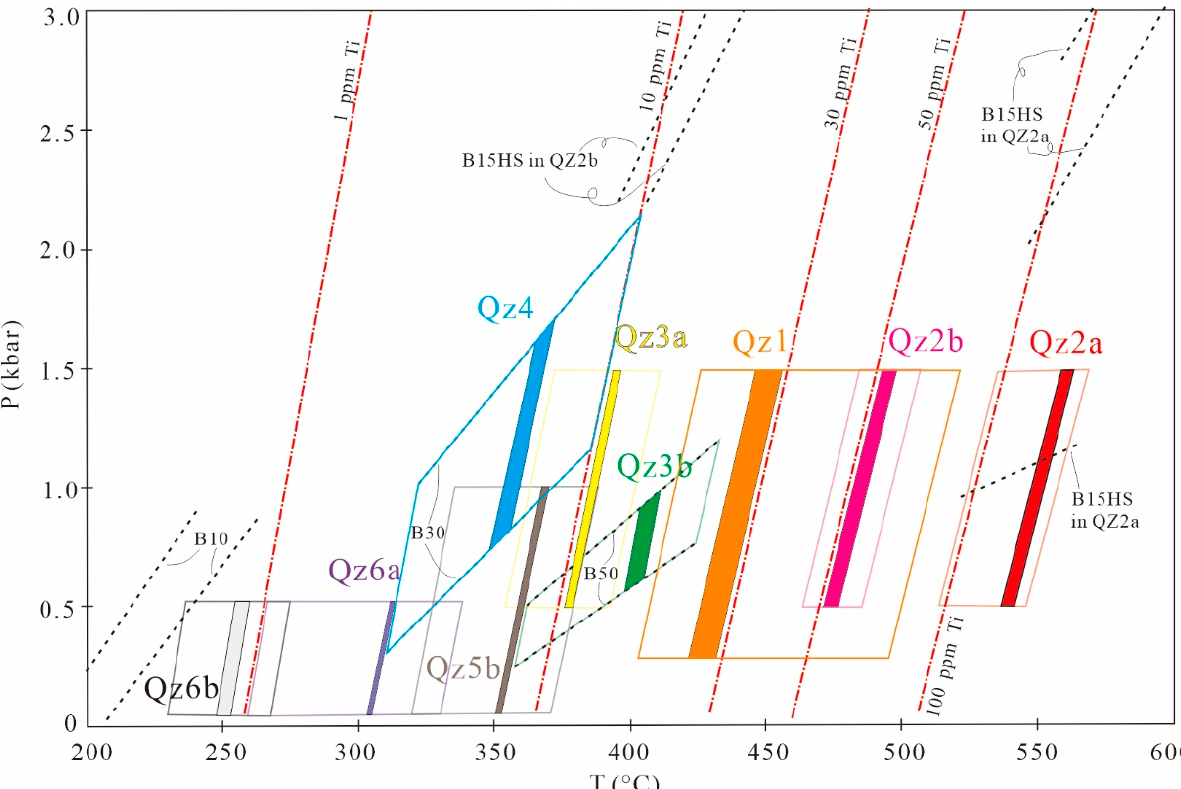
Figure 10. Pressure and temperature estimates by combining TitaniQ isopleths (dash-dotted lines in red) and fluid inclusion isochores (dash lines in black). Ti isopleths of 1 ppm, 10 ppm, 30 ppm, 50 ppm, and 100 ppm are shown; isochores of B15HS inclusions in both Qz2a and Qz2b, B50 inclusions in Qz3b, B30 inclusions in Qz4, and B10 inclusions are shown. The minimum and maximum range (solid open diamonds in colors) as well as an averaged range (solid color-filled) of Ti contents for all quartz generations are shown. Orange indicates Qz1, red indicates Qz2a, pink indicates Qz2b, yellow indicates Qz3a, green indicates Qz3b, blue indicates Qz4, dark brown indicates Qz5b, purple indicates Qz6a, and grey indicates Qz6b. Note that only Qz3a and Qz4 had reliable fluid inclusion isochore data that allowed for the use of the interception method. For other quartz generations, a pressure range was assumed to produce a reliable temperature